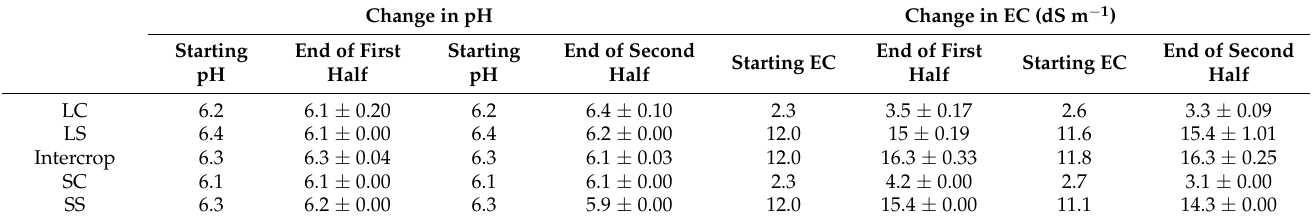
Table 1. Changes in solution pH and electrical conductivity (EC) over the 4-week trial with a complete replacement of the solutions at 2 weeks. Values are means ± SEM.